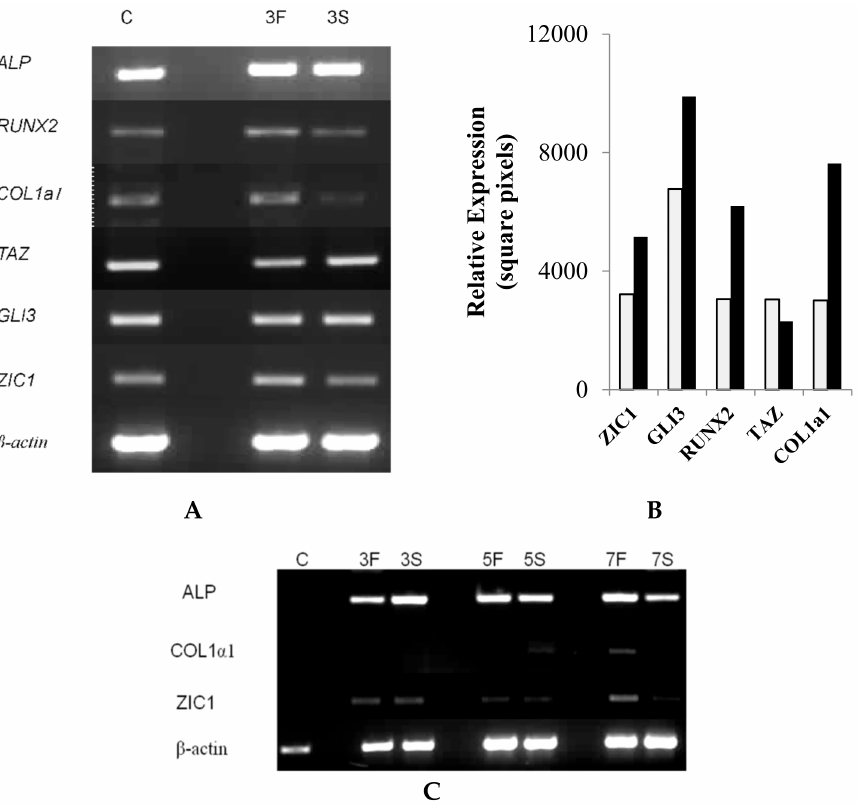
Figure 3. The effect of fluid shear stress (FSS) on osteogenic genes. ( A ) Rat osteoprogenitor cells were cultured in osteogenic medium and subjected to FSS (F). Control cells are labelled S (stationary). The cells subjected to FSS for three days (lane 3F) had induction of the key osteogenic marker genes Runx2, ALP and Col1a1 when compared to controls (lane C). ( B ) The induction was confirmed by qRT-PCR in the FSS and control stationary cells. ( C ) Cells cultured in normal non-osteogenic medium, subjected to similar magnitude of FSS, showed no evidence of Zic1 or Col1a1 induction over three days (lane 3F vs. 3S). However, after prolonged shear stress, there was an induction of Col1a1 , as well as ZIC1 , in these cells (lanes 5F, 5S, 7F and